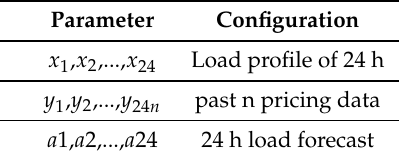
Table 1. Training Data